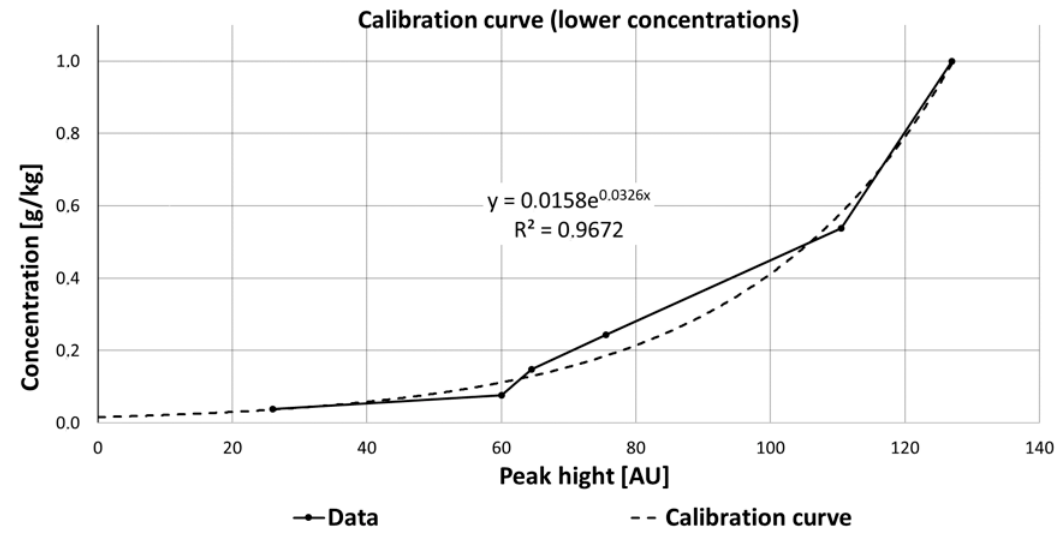
Figure 15. Calibration curve of carbamazepine at lower concentrations, fitted with an exponential function, which is described by the equation y = 0.0158e 0.0326x .